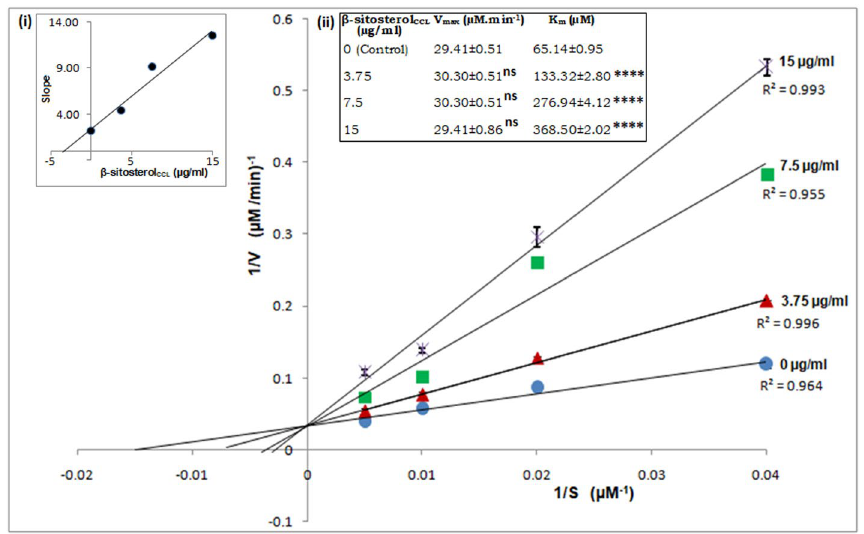
Figure 8. Kinetic analysis of Ld TryR inhibition. Lineweaver–Burk plot of Ld TryR inhibition by β-sitosterol CCL represents the competitive type. T(S) 2 was used as the substrate at 25, 50, 100, and 200 µM, and the concentrations of β-sitosterol CCL were 0, 3.75, 7.5 and 15 µg/ml. S, substrate concentration (µM); V, reaction velocity (µmol/min); R 2 , coefficient of determination. The graph in the inset (i) is the secondary replot of the slope of the Lineweaver–Burk plots versus various concentrations of β-sitosterol CCL, and the value of the inhibition constant (K i ) was calculated as 3.5 µg/ml (8.43 µM). The inset (ii) depicts the kinetic parameters (V max and K m ) of Ld TryR inhibition in the presence of different concentrations of β-sitosterol CCL . The statistical significance of the V max and K m values was calculated in comparison to the control by using one-way ANOVA with Dunnett’s multiple comparison tests. The values are statistically significant, where **** indicates p < 0.0001; “ns” indicates values that are not statistically significant. Herein, values are shown as the mean ± S.D. of three independent